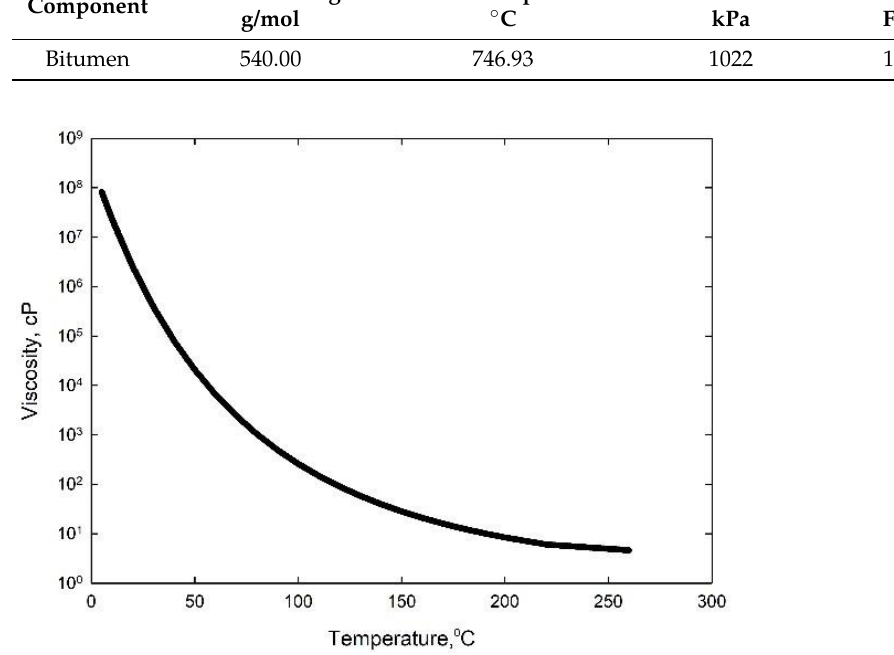
Figure 2. Bitumen viscosity as a function of temperature indicating that bitumen viscosity decreases significantly with the increase in temperature. Table 1. Reservoir properties in the simulation model.